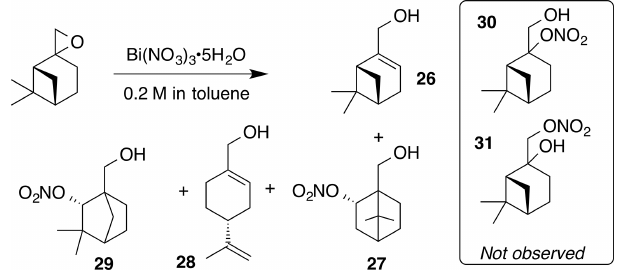
Figure 8. Nitration of β -pinene